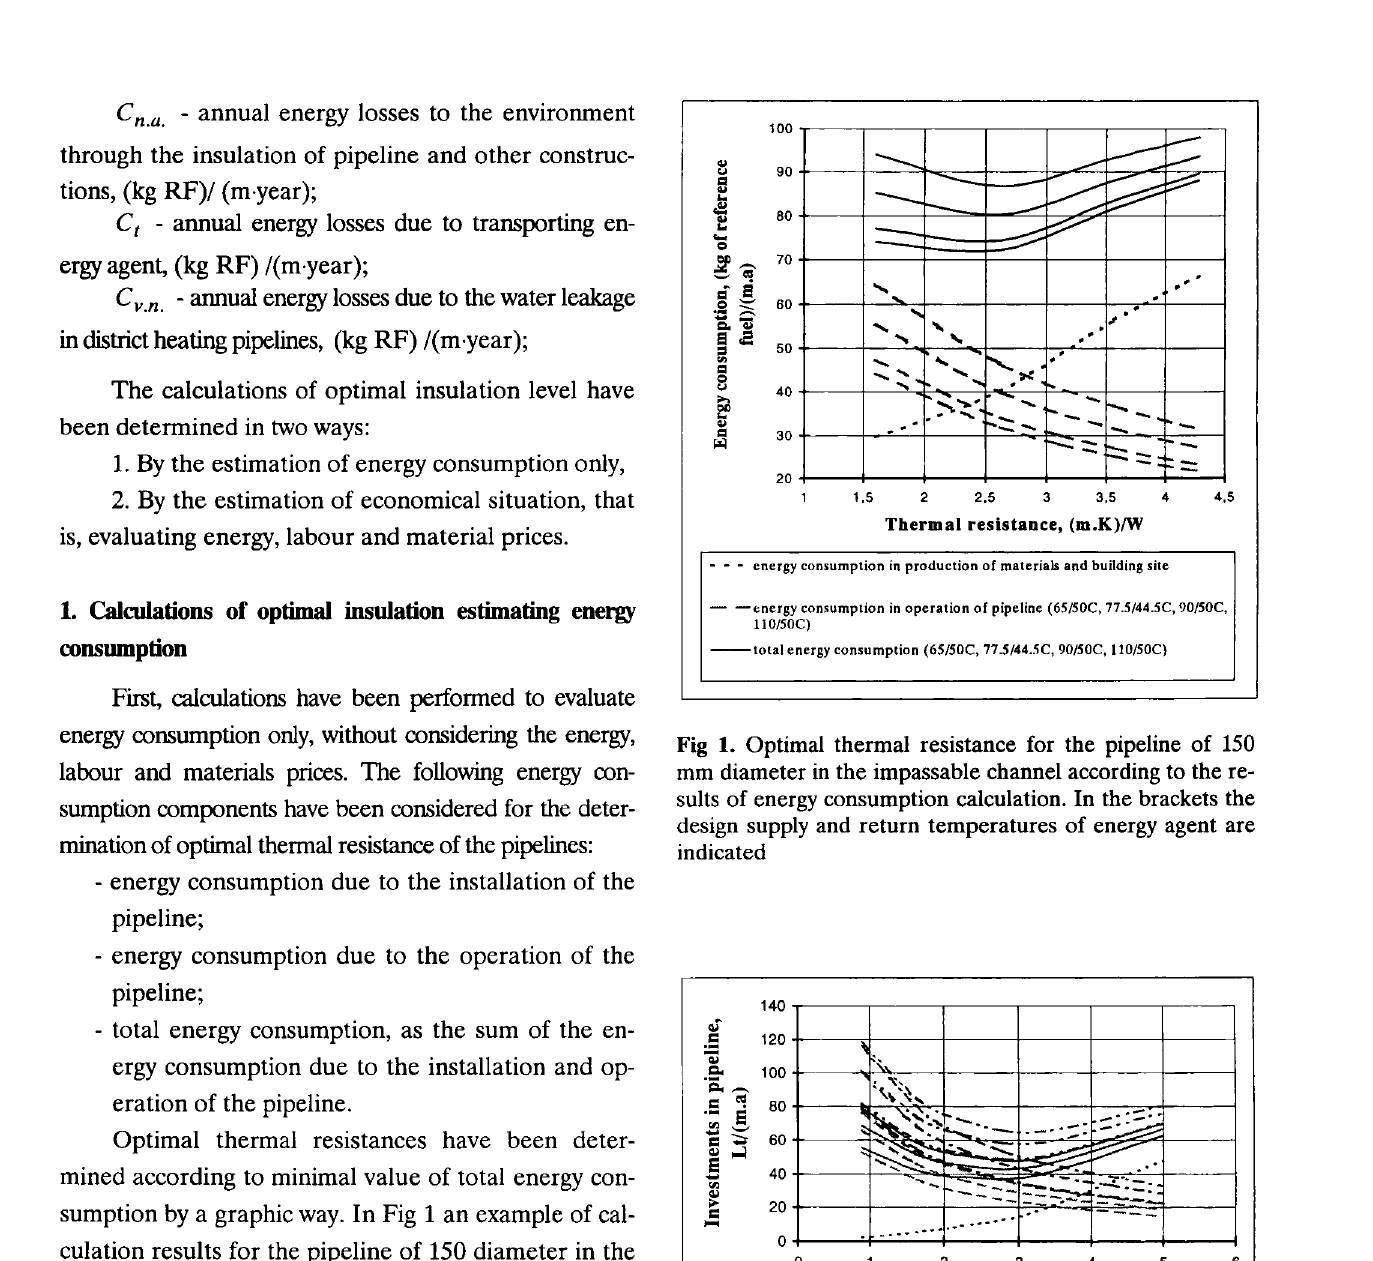
Fig 2. Optimal thermal resistance for the pipeline of 150 mm diameter in the impassable channel according to the results of economical calculation